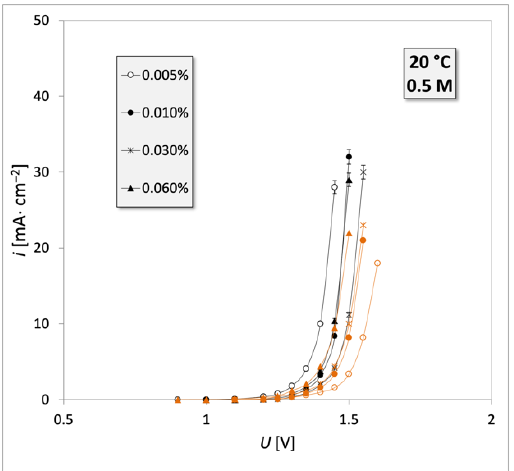
Figure 2. Electro-oxidation curves of Syntanol DS-10 detergent (orange lines) and waste engine oil emulsion (black lines) at the temperature of 20 °C in a 0.5 M aqueous solution of H 2 SO 4 , for various concentrations of detergent and emulsion (0.005%, 0.010%, 0.030%, and 0.060% of reactor volume).